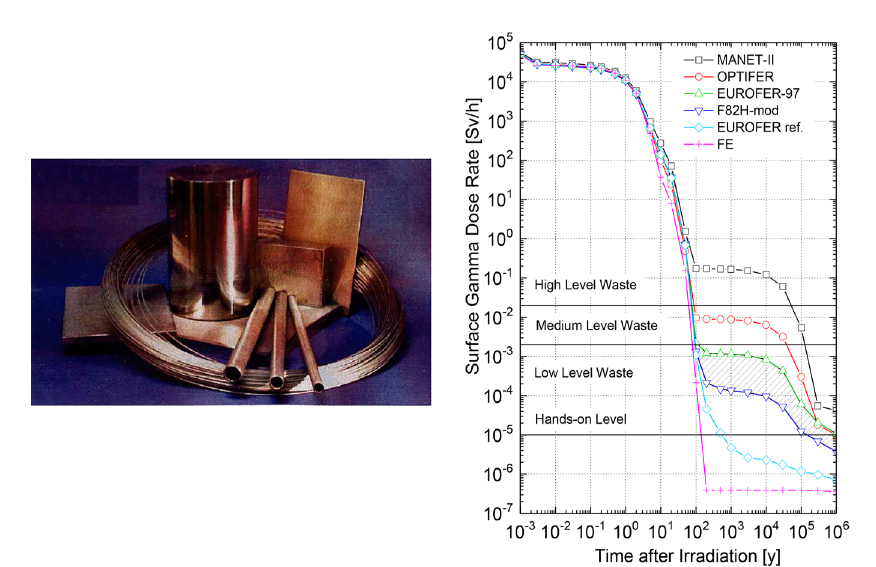
Fig. 6. – (a) Picture of EUROFER components (courtesy EUROfusion) and (b) contact dose rate vs. time for different steels from ref.